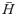
Left: Plot of the statistical complexity CLMC, entropy H and disequilibrium D versus the probability of obtaining a head outcome in a biased coin (N = 2 states) system. To calculating CLMC in a 2-state system we can simply rewrite Eqs (11) and (12) as H = −[p(head)log p(head) + p(tail)log p(tail)] and D = {[p(head) − 1/2]2 + [p(tail) − 1/2]2}. Since we have p(head) = 1 − p(tail), the graph is symmetrical about p(head) = 0.5. Right: Plot of the statistical complexity CLMC versus the normalised entropy H¯ for N = 2 and N = 3 states systems.